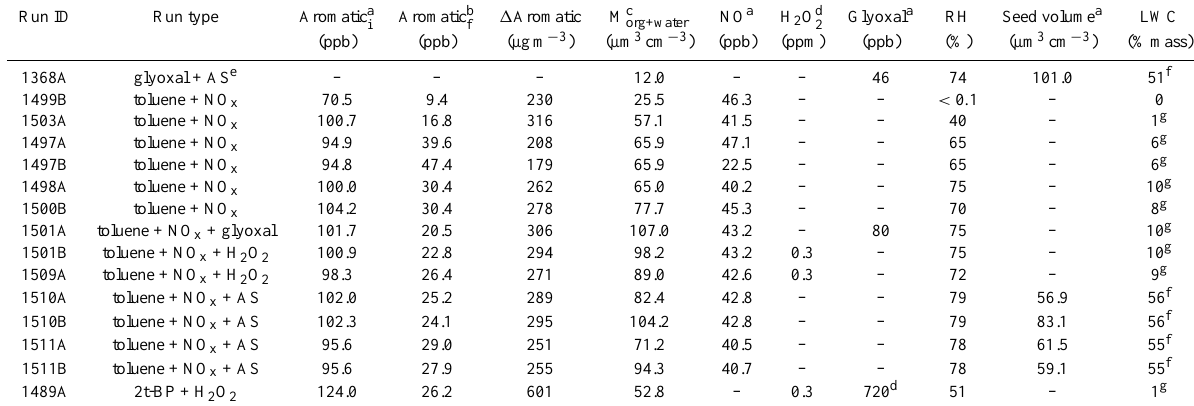
Table 1. Experimental test matrix.